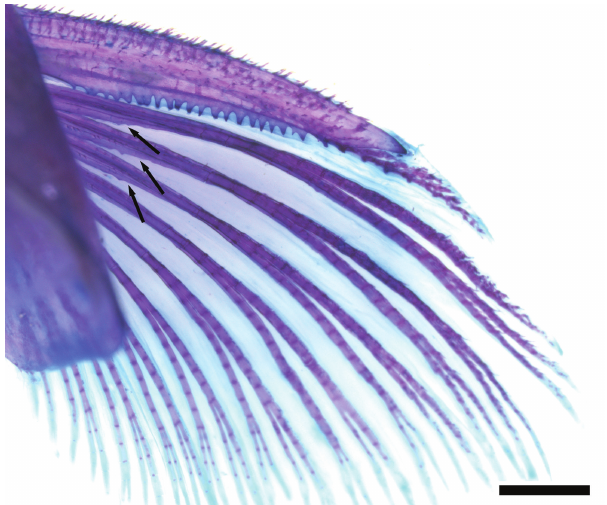
Fig. 5. Aspidoras kiriri , NUP 18246, c&s paratype, 30.4 mm SL, showing the serration pattern of pectoral spine. Arrows indicate laminar expansion at base of branched rays. Scale bar = 1